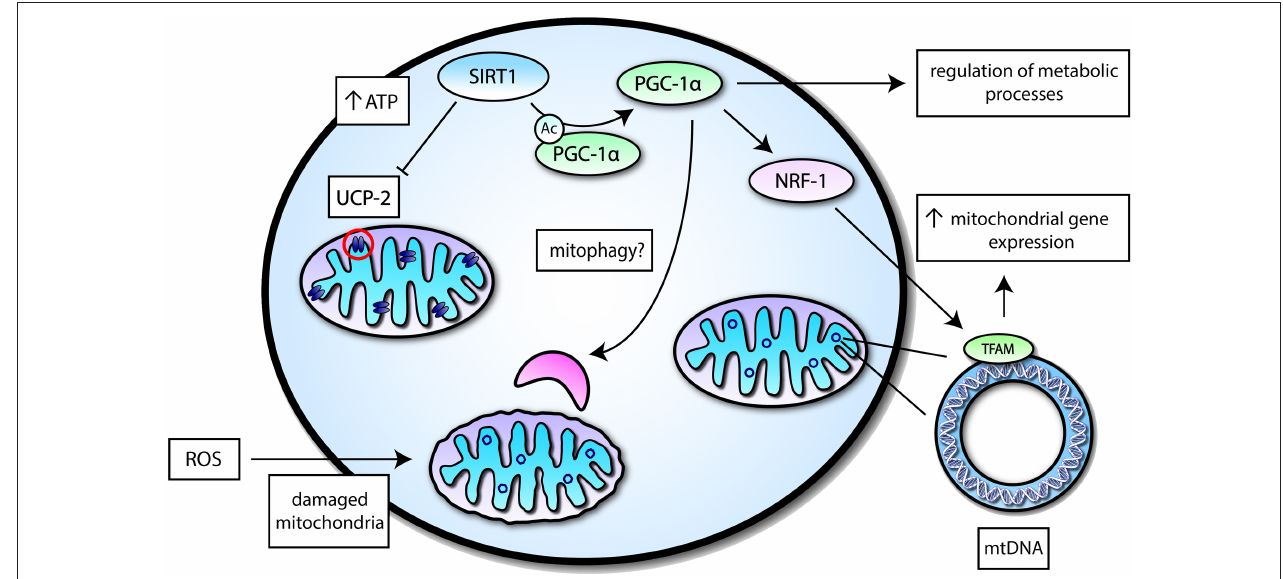
FIGURE 2 | A simplified overview of mitochondrial functions mediated by SIRT1 activity. SIRT1 may interact with transcription factors or mitochondrial proteins to induce different effects related to mitochondrial function—a select few of these proteins are highlighted. SIRT1 can suppress Uncoupling protein 2 (UCP-2) in the inner mitochondrial membrane to increase levels of ATP, which is important for energy metabolism. SIRT1 may also deacetylate Peroxisome proliferator-activated receptor γ (PPAR γ ) coactivator-1 α (PGC-1 α ) to induce its activation and augment mitochondrial biogenesis by increasing mitochondrial gene expression via Nuclear respiratory factor 1 (NRF-1) and Nuclear-encoded mitochondrial transcription factor A (TFAM). PGC-1 α itself can regulate different metabolic processes and may potentially play a role in